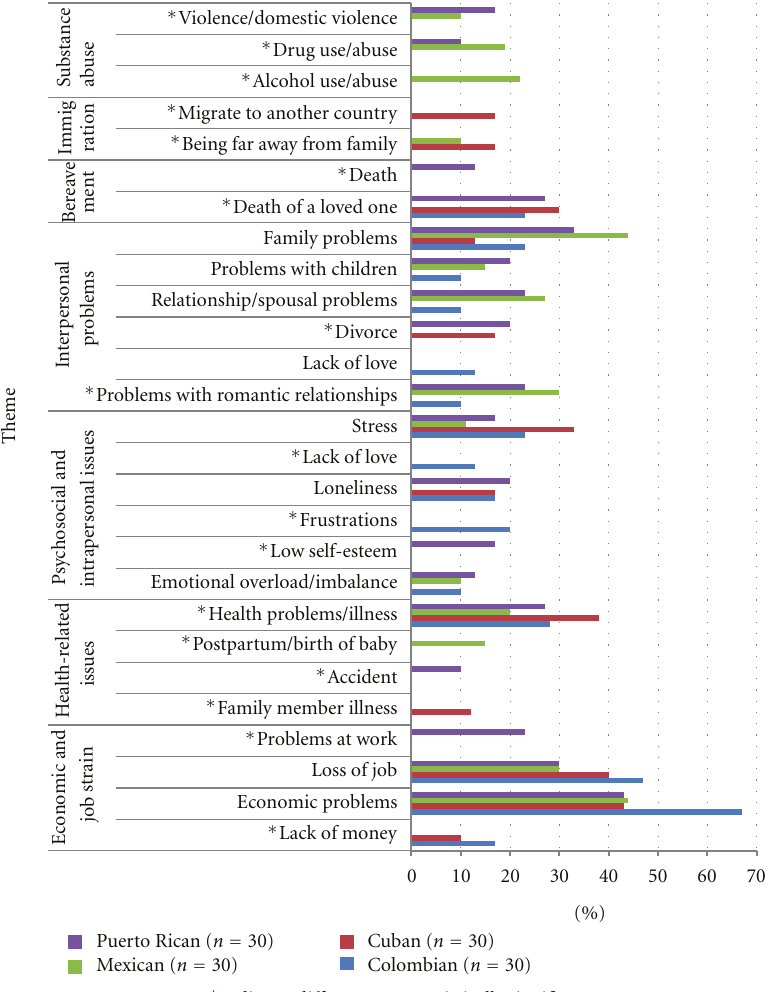
Figure 1: Most frequently listed causes of